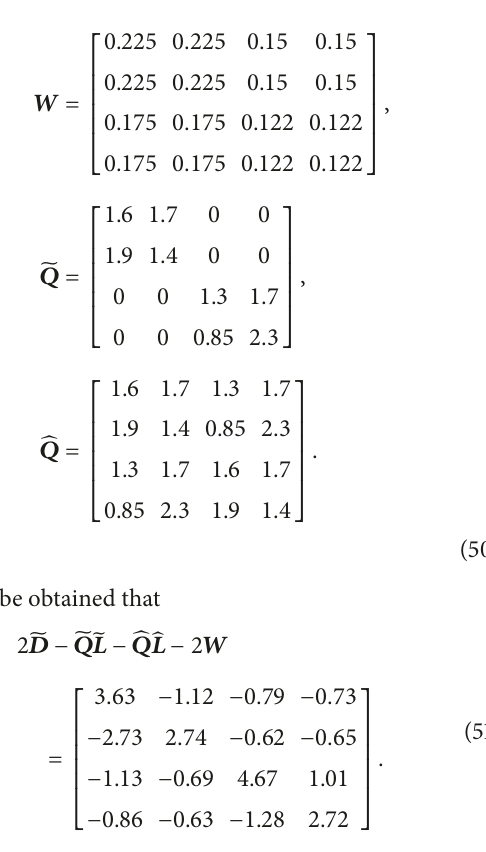
Figure 1: State curves of the real parts and imaginary parts in (48) without stochastic